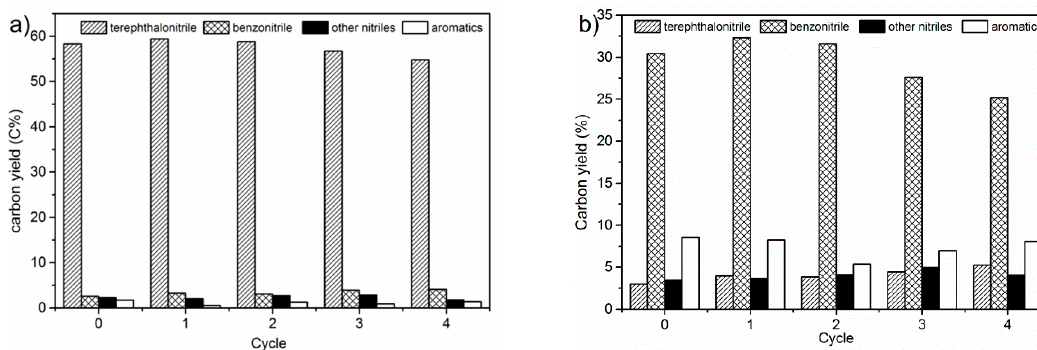
Figure 5. Yield of products vs. catalyst cycle for ( a ) terephthalonitrile at 500 °C, and ( b ) benzonitrile at 650 °C. ( ( a ) 1g 2% Ca(OH) 2 /Al 2 O 3 ; N 2 and NH 3 flow rate, 120 mL/min and 40 ml; PET feeding, 0.5